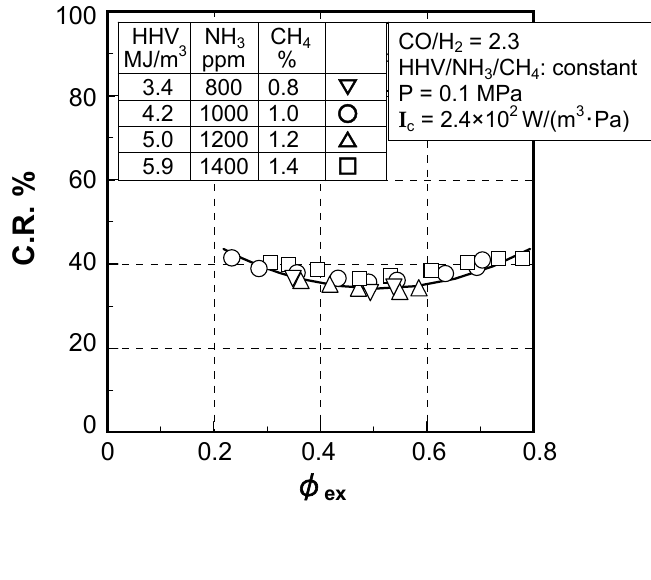
concentration on NOx emission 3